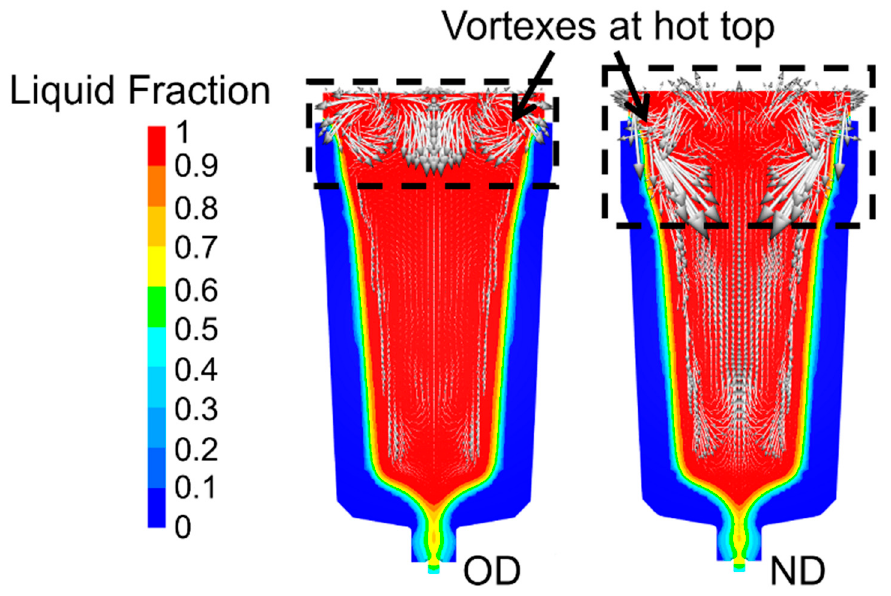
Figure 11. Liquid fractions and fluid velocity vectors of OD and ND at 45% solid fractions .